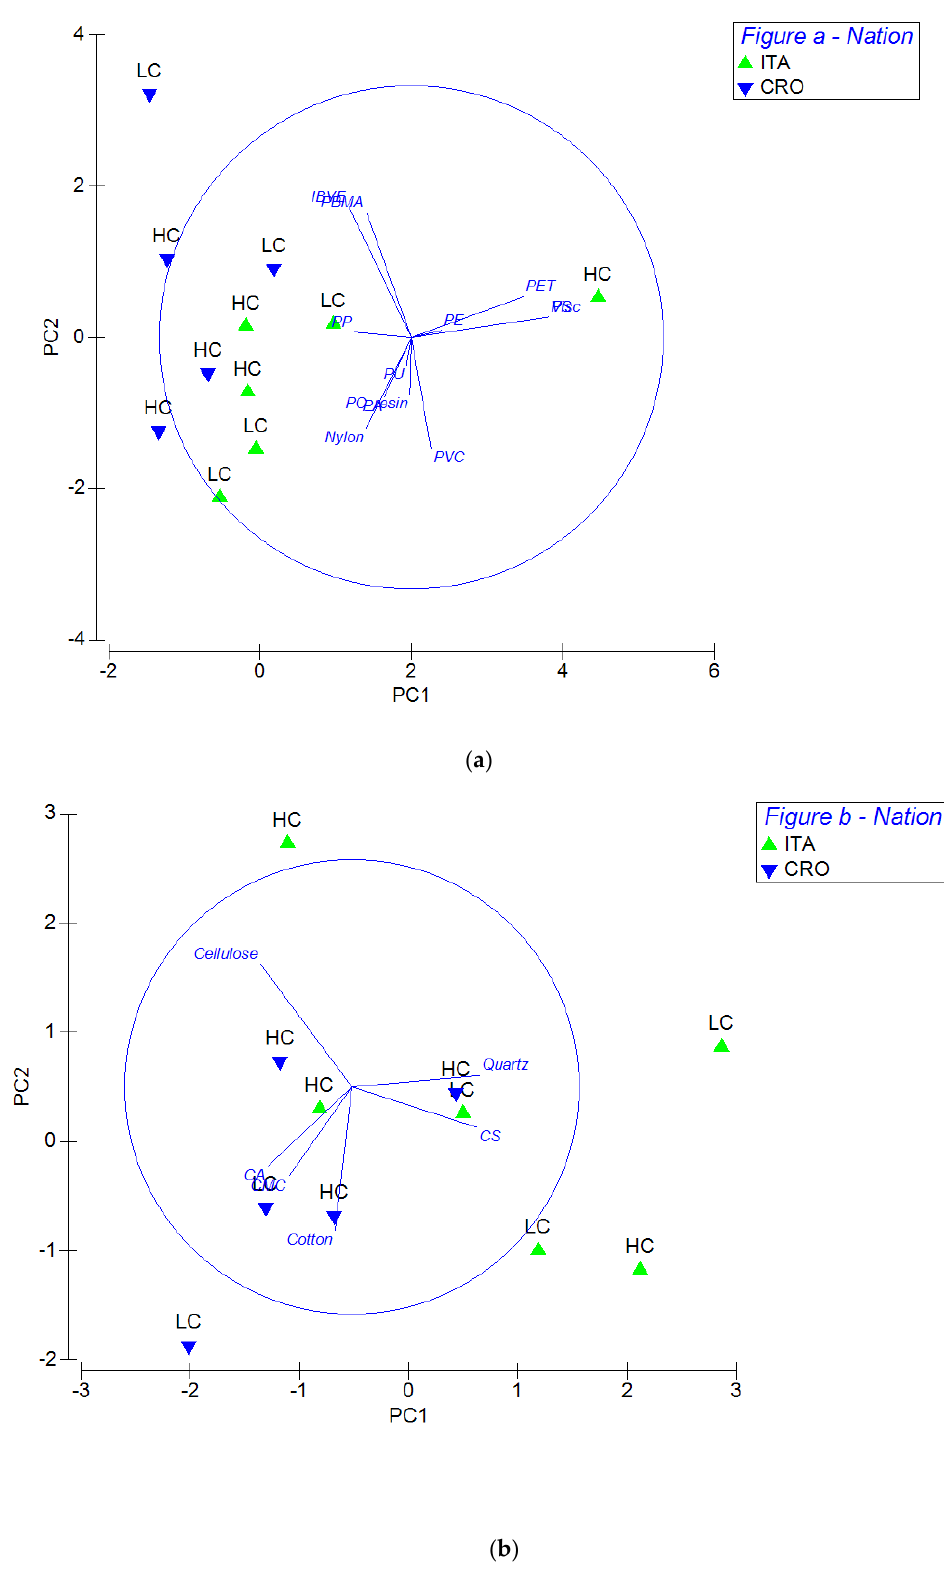
Figure 3. Principal Component Analysis performed to evaluate similarities according chemical composition of detected particles. Data used to plot PCA are related to loadings collected in this study (microparticles 10 –150 μm). ( a ) microplastics, ( b ) non-synthetic particles.